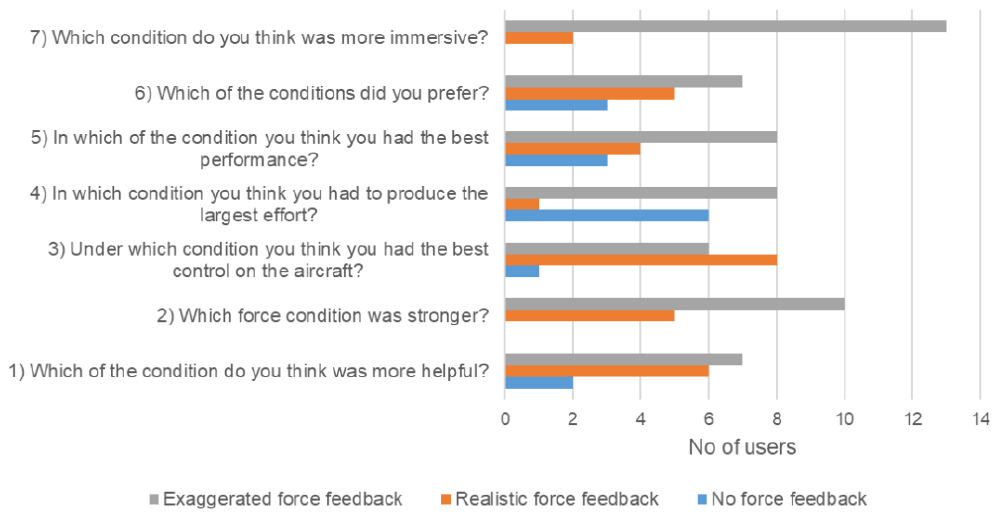
Figure 15. Operator response to subjective